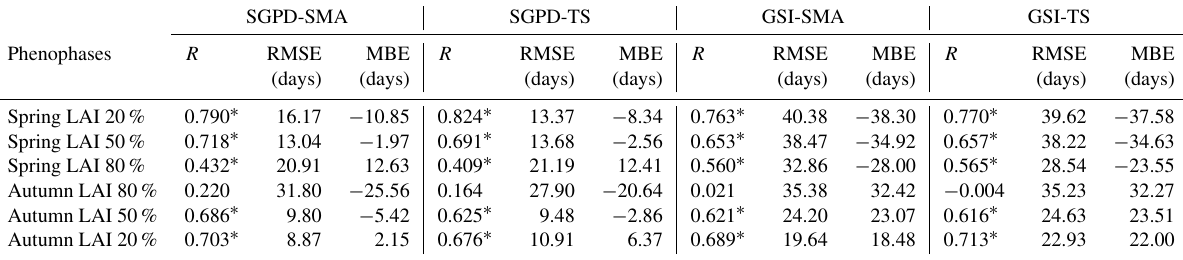
∗ Correlation is significant at the 0.001